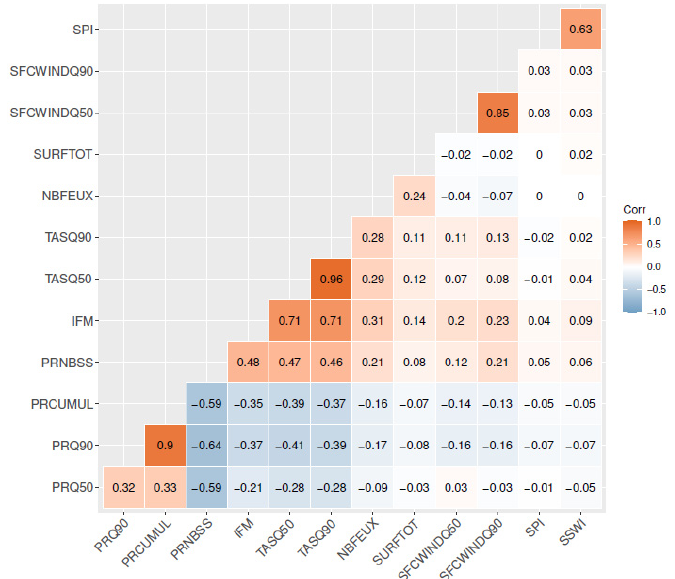
Figure 6. The correlation matrix highlights the coefficient of correlation for the different possible pairs of variables. There is a positive correlation between the FWI and the Q50/Q90 of the daily temperature (0.71). We observed a correlation between the number of days without precipitation and the number of fires (0.21).